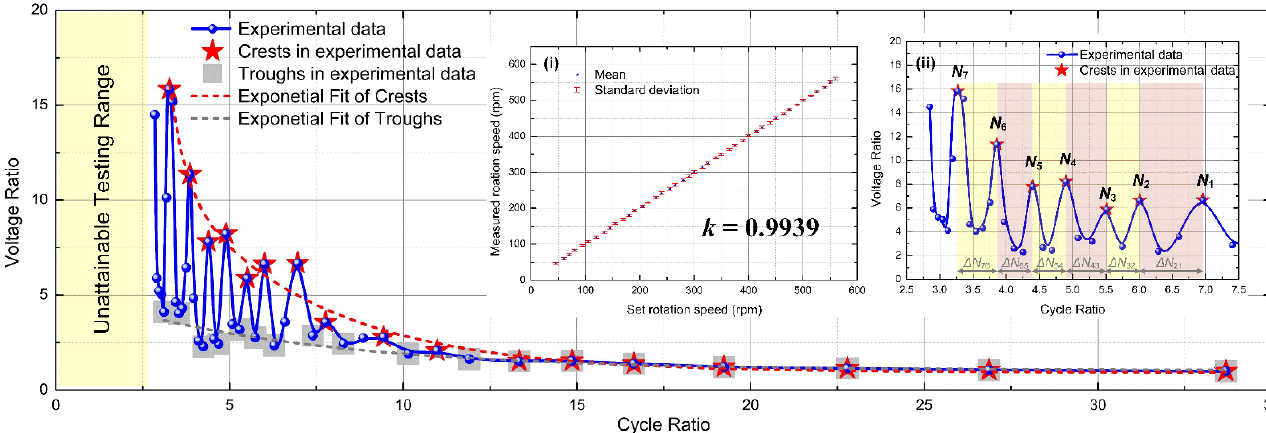
Figure 7. Characterization of measured voltage ratio vs. cycle ratio, with inset ( i ) sensitivity of the triboelectric tachometer based on time measurement of voltage spikes; ( ii ) close-up of the voltage ratio oscillation in the range of 2.5–7.5 cycle ratio.